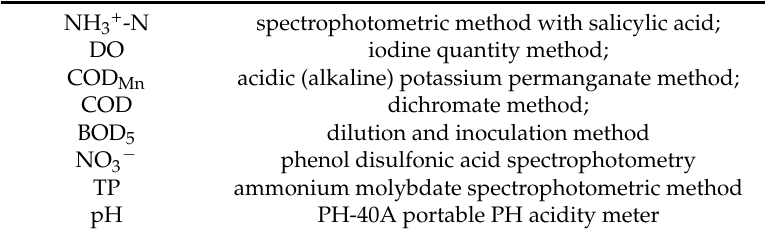
Table 1. Water quality experiment methods